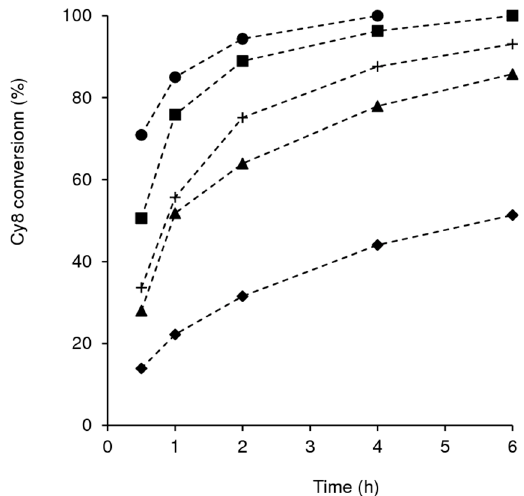
Figure 9. Kinetic profiles of the Cy8/TBHP reaction, in the presence of Mo-TUD(IWI-acac) ( ● ), Mo-TUD(IWI-amm) ( ∎ ), Mo-TUD(IWI-ahm) ( ▲ ), Mo-TUD(HT) ( ♦ ), or Mo-hierBEA (+), at 70 °C. Epoxide selectivity was always 100%.